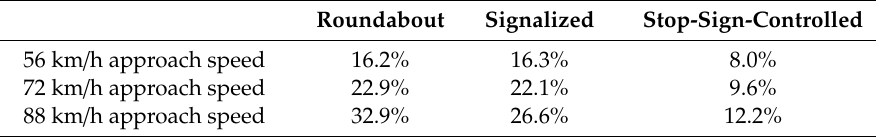
Figure 5. BEV ′ s regenerative energy generated for different intersection control strategies and Figure 5. BEV’s regenerative energy generated for di ff erent intersection control strategies and approach speeds. approach speeds. Table 1. Percentage of regenerated energy compared to total BEV energy Table 1. Percentage of regenerated energy compared to total BEV energy consumption.